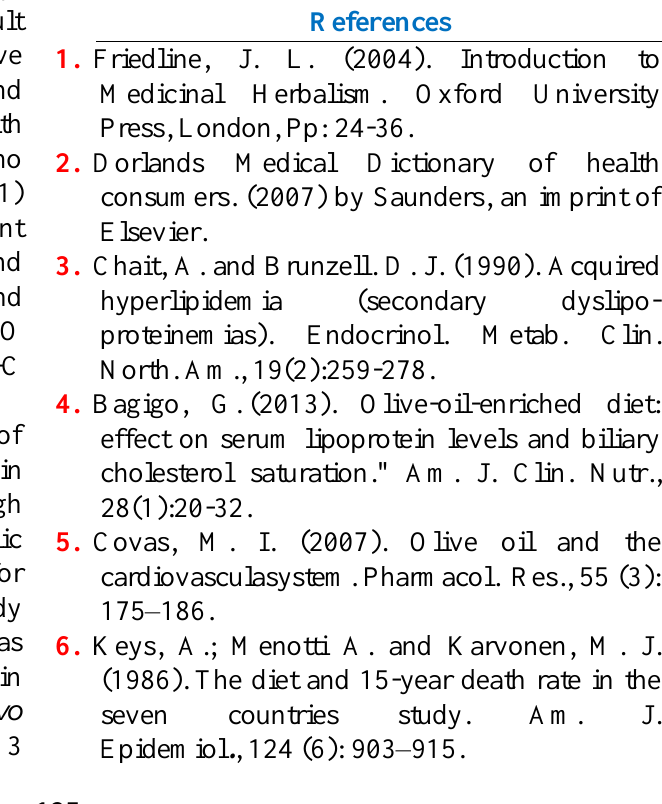
n=5 P<0.05 Different letters refer to significant differences among